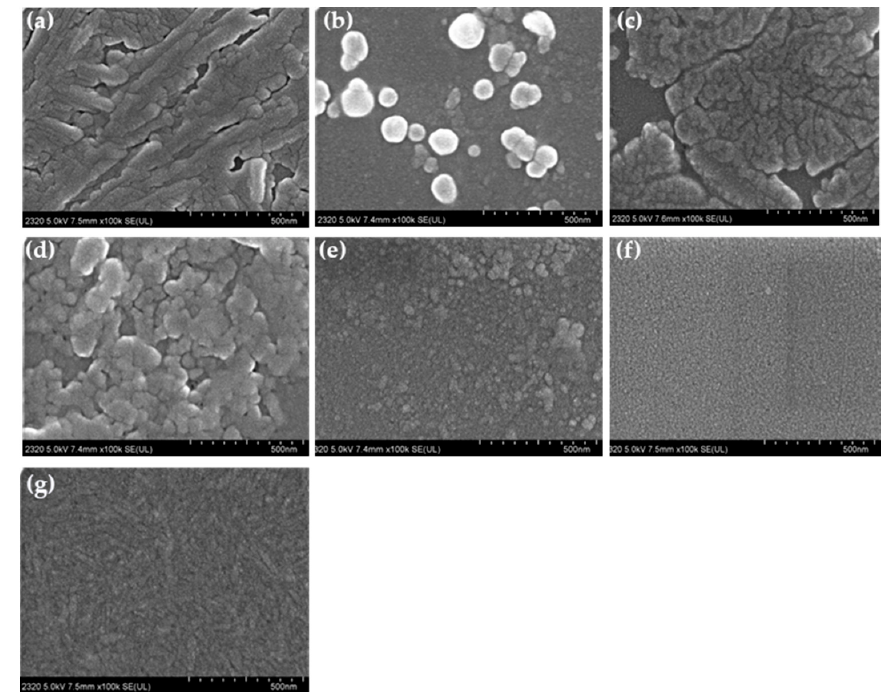
Figure 5. SEM morphology of each porphyrin in film state ( a ) TPP, ( b ) TAPP, ( c ) TBPP, ( d ) TCPP, ( e ) THPP, ( f ) TMPP, ( g ) TSPP deposited on glass substrate by spin-coating (1600 rpm).